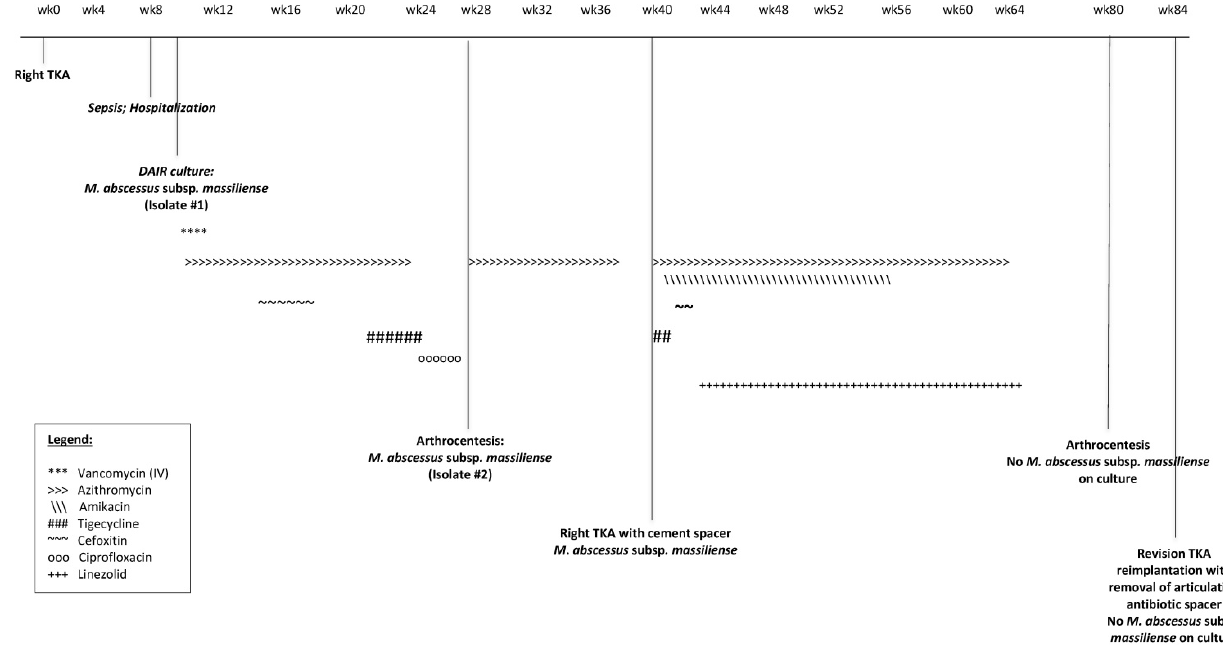
Figure 1: Timeline of Management and Interventions for M. abscessus subsp. massiliense Knee PJI at Both